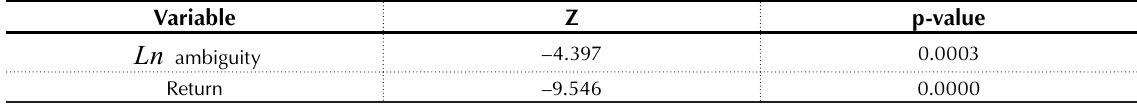
Table 5. Augmented Dickey-Fuller test result